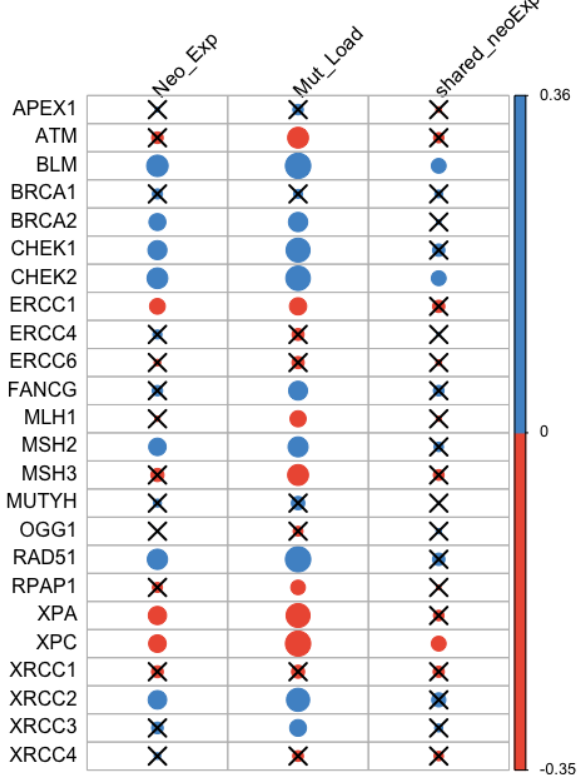
Figure 1. Correlation between neoantigen expression, mutation load, the expression of the most shared neoantigens and DNA repair gene expression. Blue and orange represent positive and negative correlation, respectively. The size of the dot is proportional to the magnitude of the correlation. Insignificant associations were marked with black crosses at the significance level of 0.05.